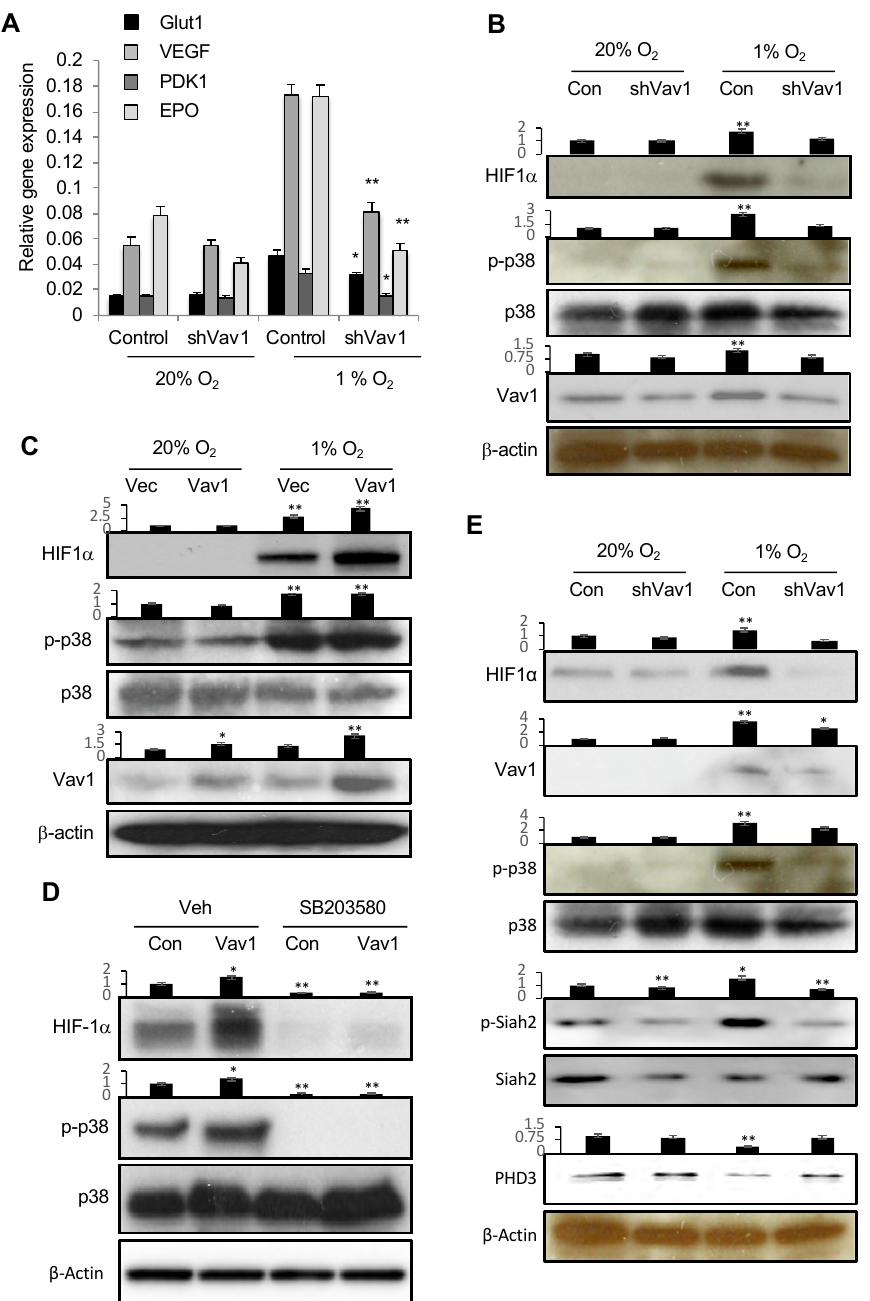
Figure 4. Vav1 regulates HIF1 α via p38 MAPK. ( A ) HUVECs were transfected with a control